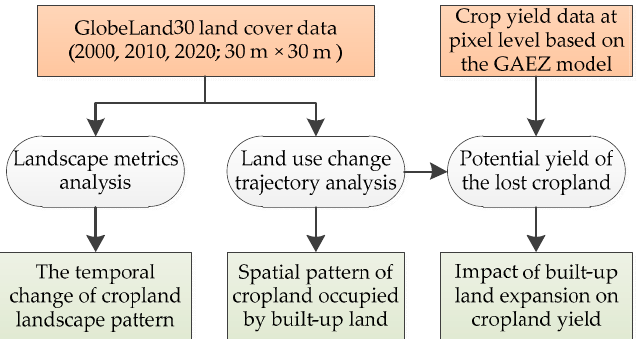
Figure 2. The framework of this study. The orange rectangles on the upper are input data, the green rectangles on the bottom are outputs, and the grey ellipse in the middle are methods and middle output.